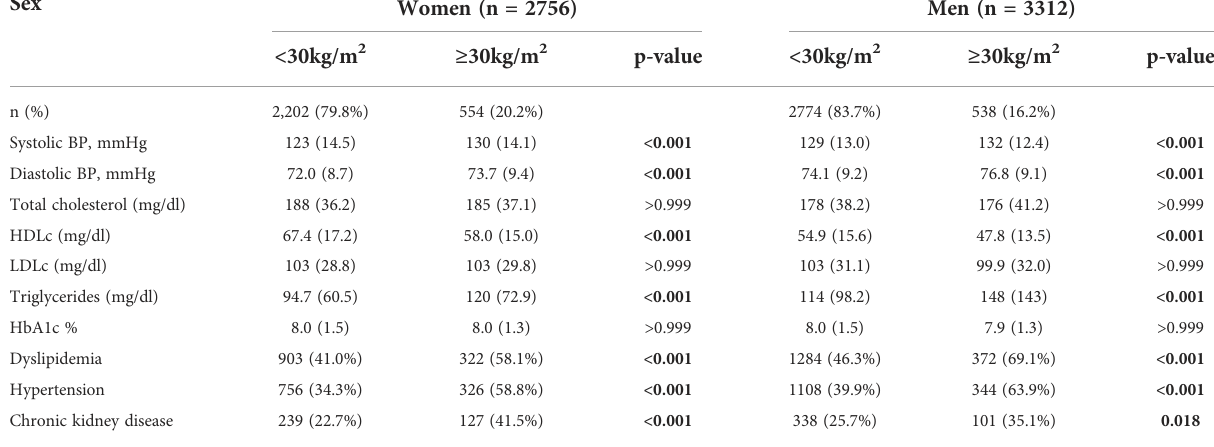
TABLE 3A Prevalence of obesity and clinical characteristics according to sex.